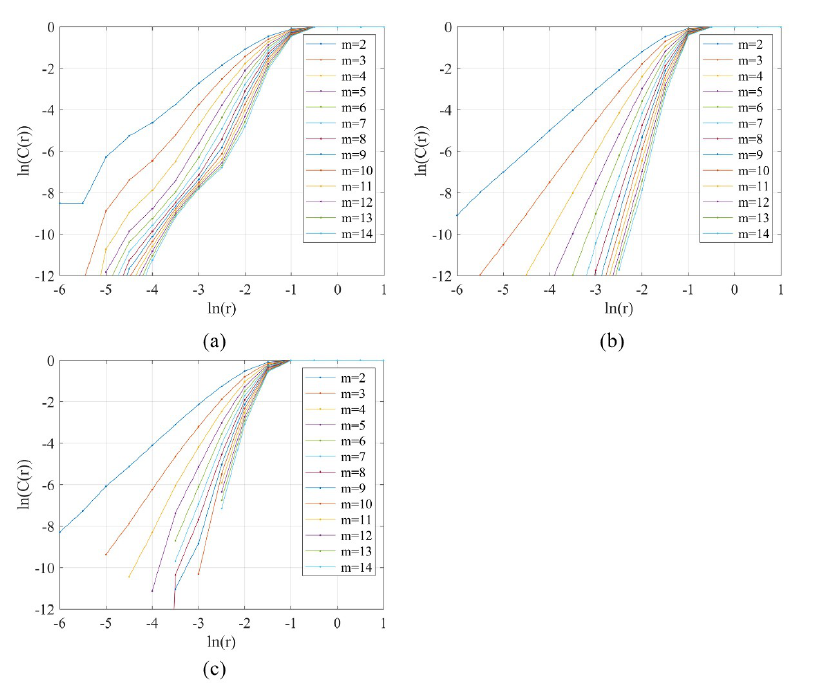
Figure 3. The curves of ln Cn ( r ) and ln r as m increases for the EDH time series at three different timescales: ( a ) hourly, ( b ) daily, and ( c )